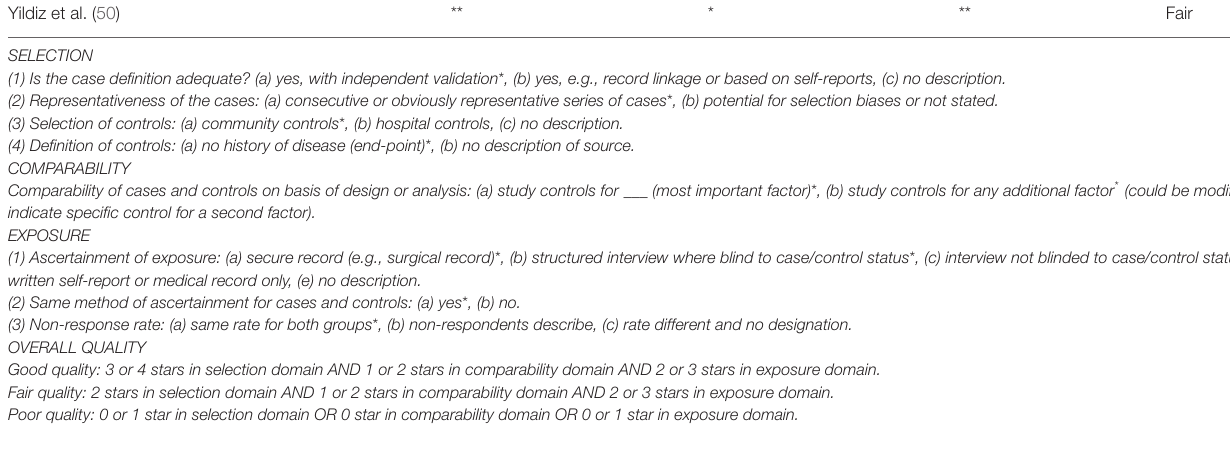
Frontiers in Cardiovascular Medicine |